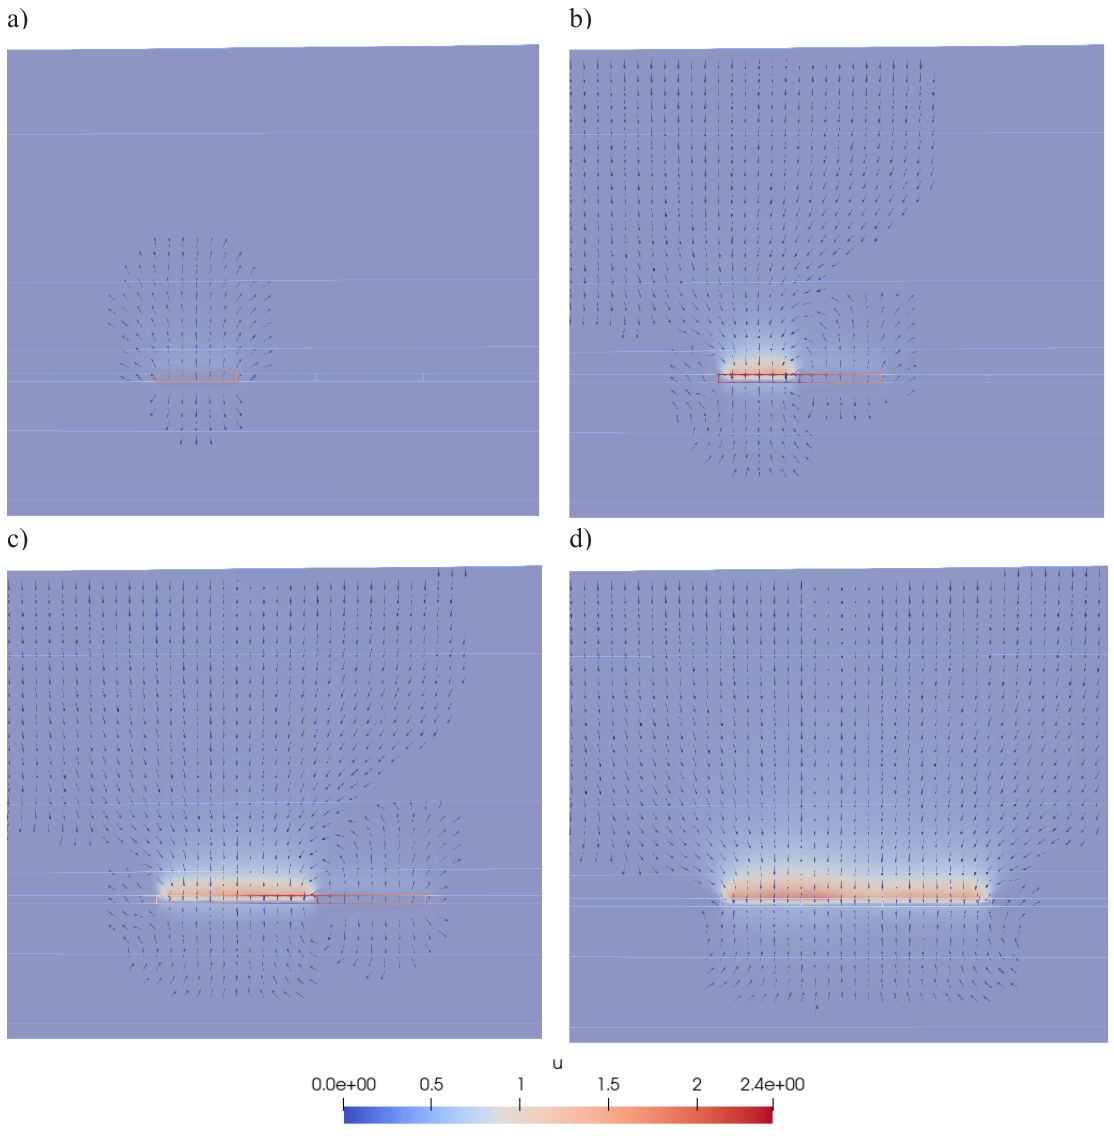
Figure 9: Distribution of displacements (m) in the cross-section at y = 750 m at times a) 1 month, b) 0.5 year, c) 1 year, d)2